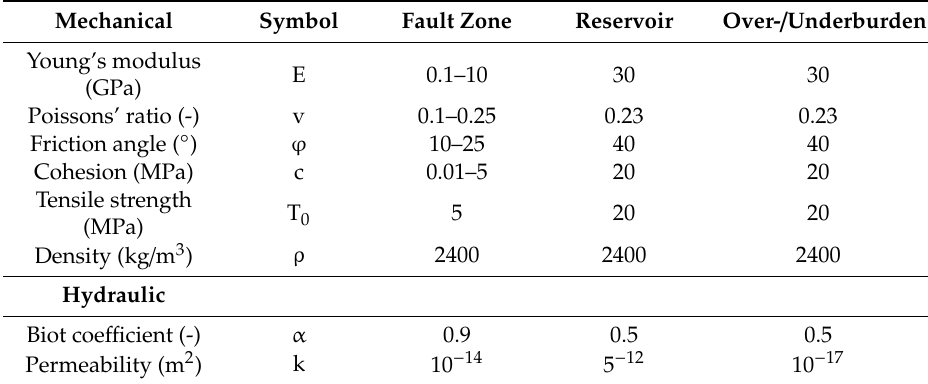
Table 1. Hydraulic and mechanical parameters used for the three model units.